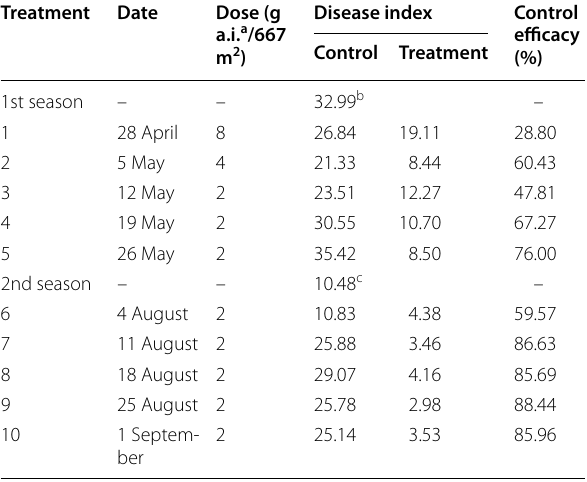
Table 1 Control efficacy of different doses of ZJ0712 against cucumber powdery mildew in two successive growing seasons